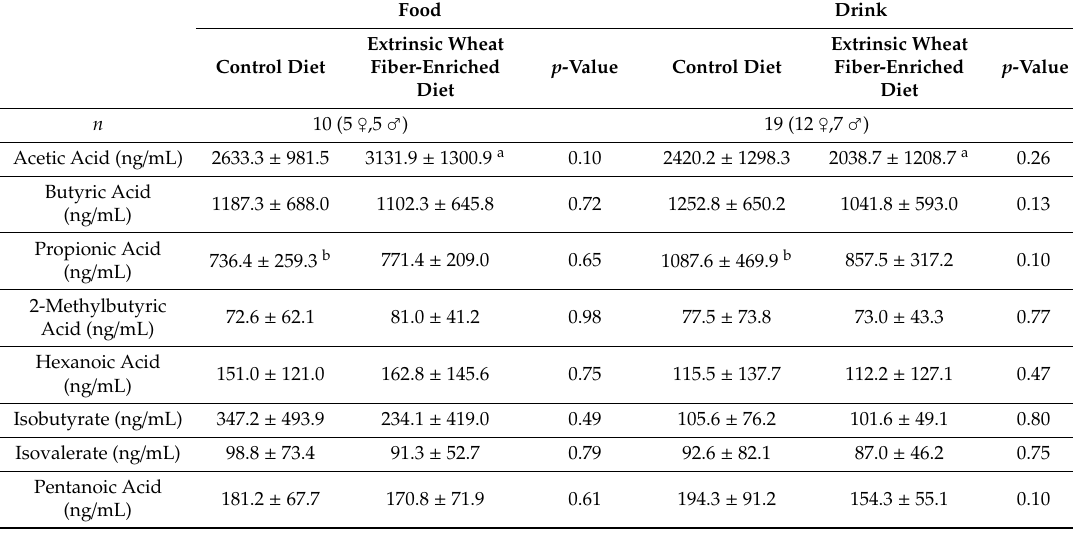
Table 2. SCFA concentrations measured in fecal